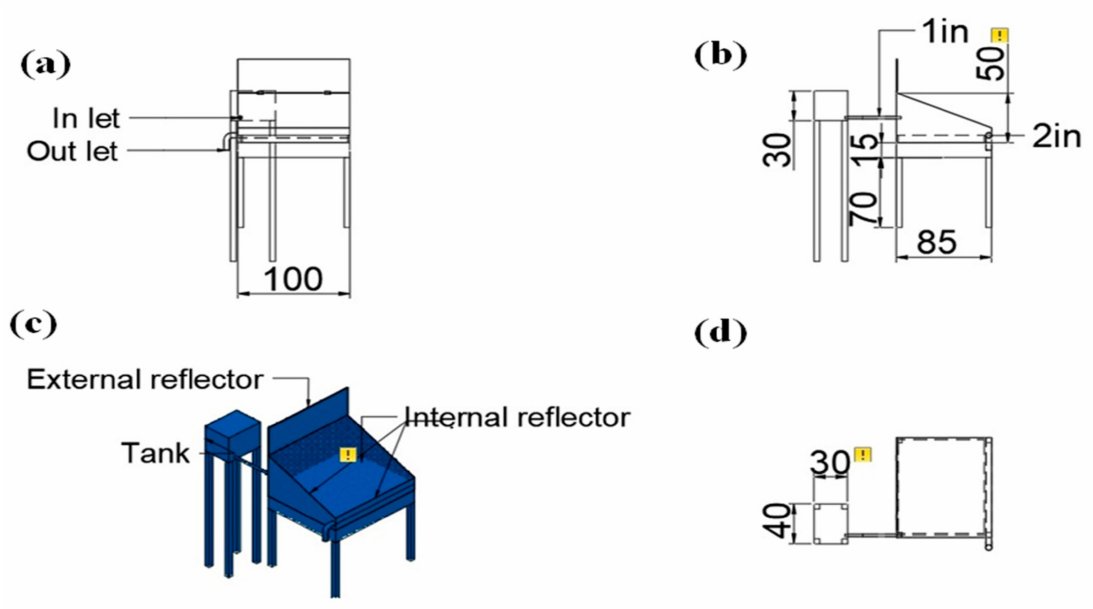
Figure 2. AutoCAD designing of fabricated solar still ( a – d